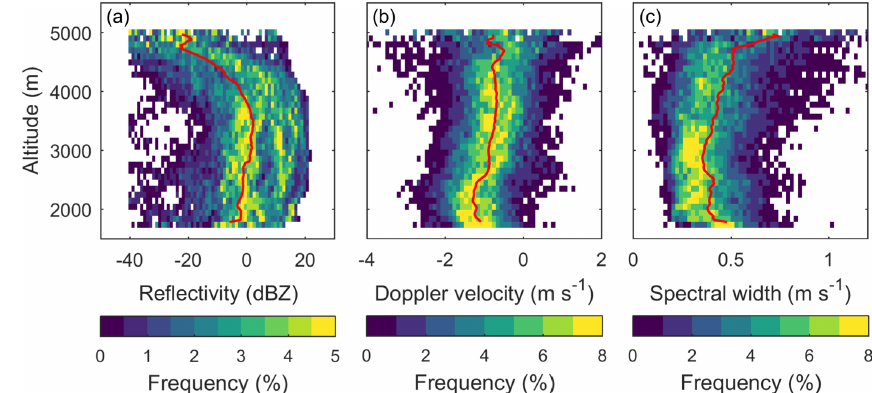
Figure 5. CFADs of the radar reflectivity (a) , Doppler velocity (b) and spectral width (c) for the time period between 15:50 and 18:20UTC. The red line shows the mean vertical profile. The following bin sizes were applied: (1) radar reflectivity from − 40 to 30dBZ in 1dBZ intervals, (2) Doppler velocity from − 4 to 3ms − 1 in 0.1ms − 1 intervals and (3) spectral width from 0 to 1.2ms − 1 in 0.02ms − 1 intervals. A height interval of 100m was used for all radar